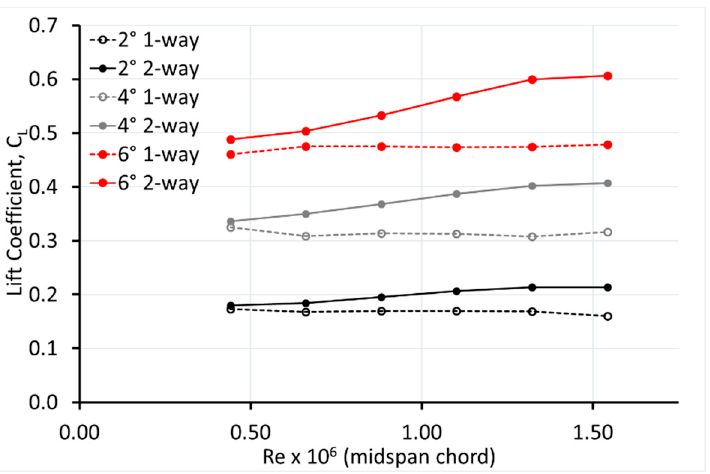
Figure 11. Lift coefficient vs. Reynold’s number.